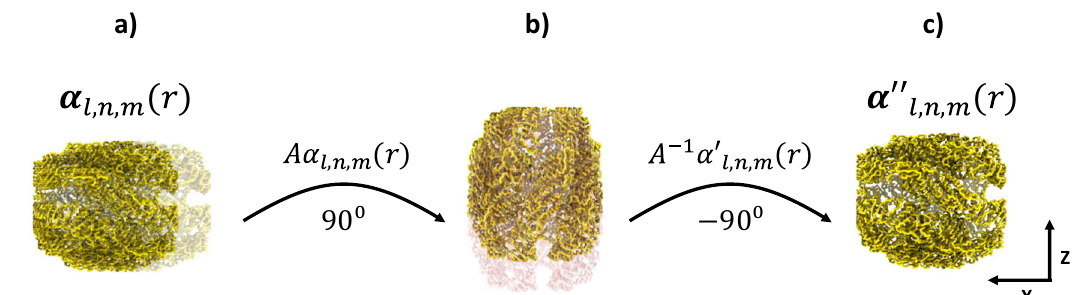
Fig. 9 | Projection direction correction work fl ow. Procedure to cancel excessive displacements associated with the projection direction in a deformation fi eld de fi ned by the coef fi cients α l , n , m r ð Þ . a Representation of a deformation fi eld with over-deformation along the X direction (projection direction). b The over- deformed volume and the associated deformation coef fi cients are rotated so that the projection direction matches the Z axis. At this point, it is possible to